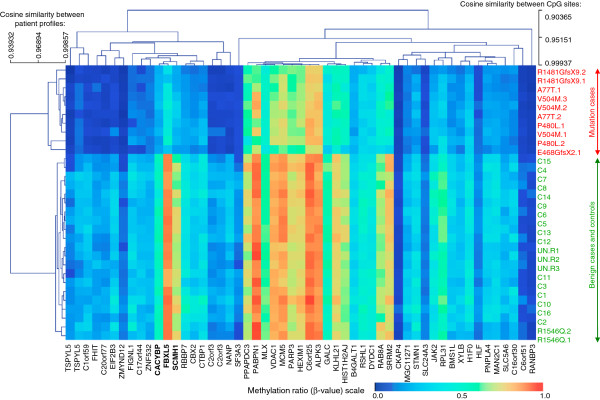
Hierarchical unsupervised clustering of 31 study samples. DNA methylation levels at the 53 most significant CpG sites were used for hierarchical unsupervised clustering. The results show a clear distinction between the 10 KDM5C mutation cases (top part), and the remaining 21 samples (bottom part), which is also indicated by the large distance between the two branches of the dendrogram on the left. DNA methylation levels corresponding to mutations are generally lower than for the controls. Interestingly, the two cases of variant of unknown clinical significance (p.R1546Q) have methylation profiles very similar to the 19 controls. Also, mutation cases from the same family do not always cluster together. The clustering was based on complete linkage and cosine distance metric.